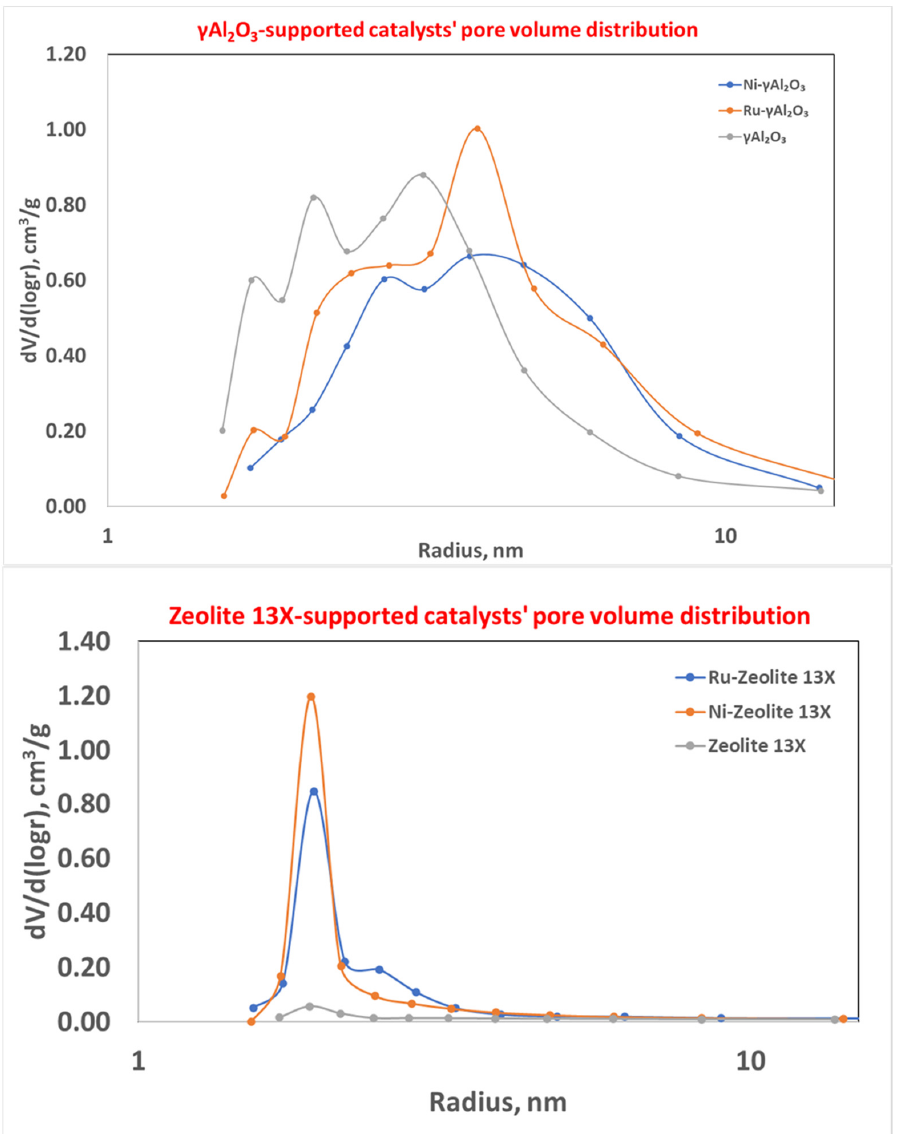
Figure 6. Mesopore size distribution for γ Al 2 O 3 - (top) and zeolite 13X-supported catalysts (bottom).